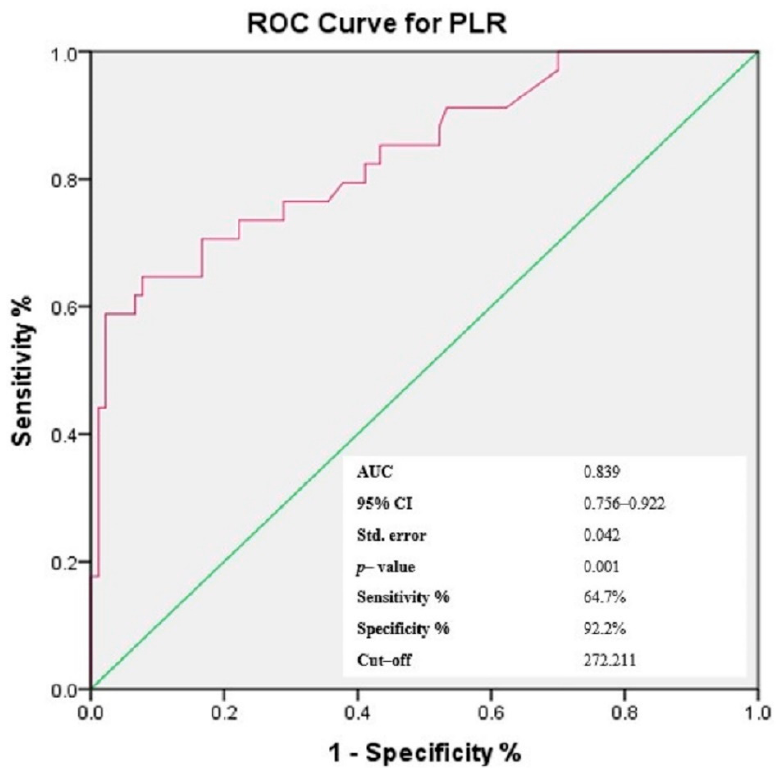
Figure 3. Receiver operating characteristic curve of PLR levels for the prediction of the cutaneous vasculitis lesions in patients with pSS.